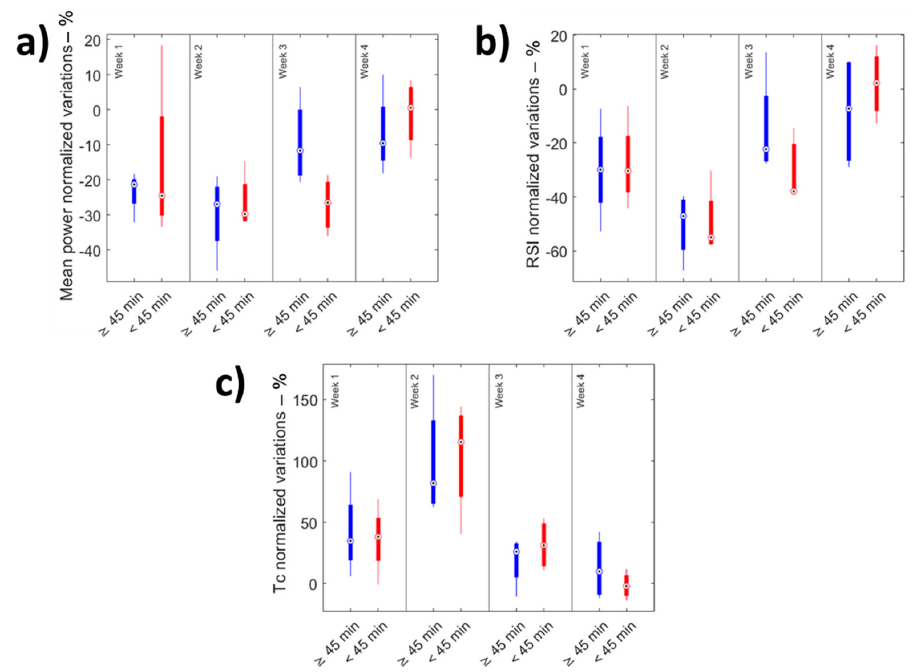
Figure 5. (a ) Mean power, ( b ) RSI, and ( c ) 𝑇 (cid:3030) normalized variations for the two different groups.